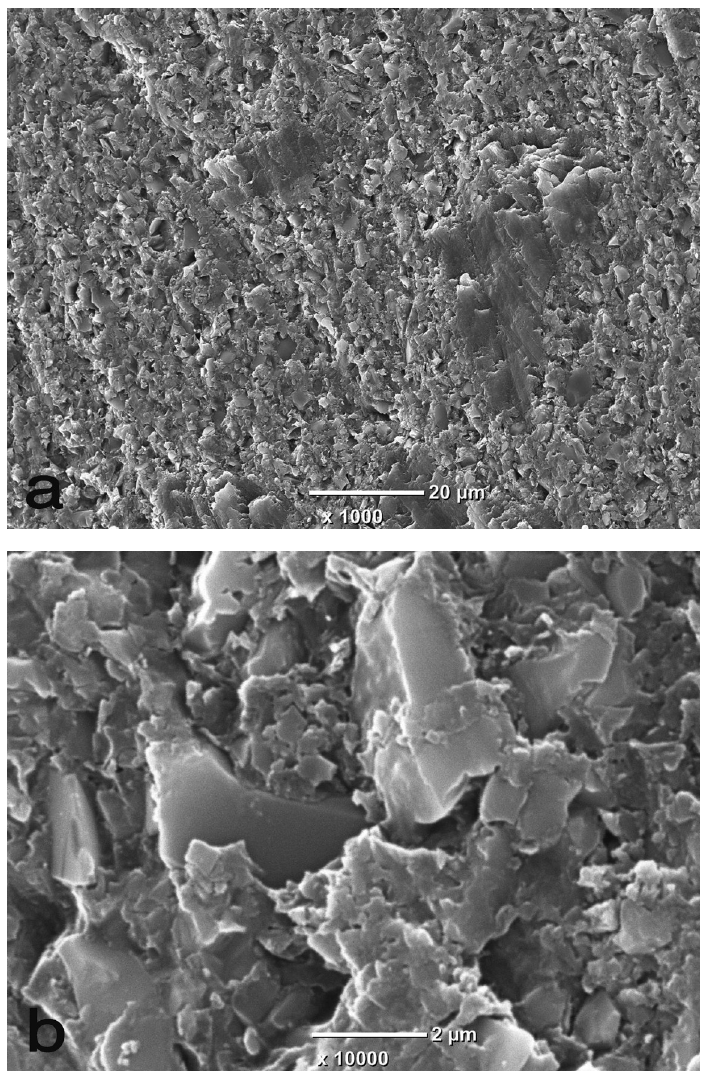
Figure 4- Scanning electron micrograph of a CAD/CAM composite specimen ground with 600-grit silicon-carbide abrasive paper. Original magnification: (a) ×1,000 and (b)